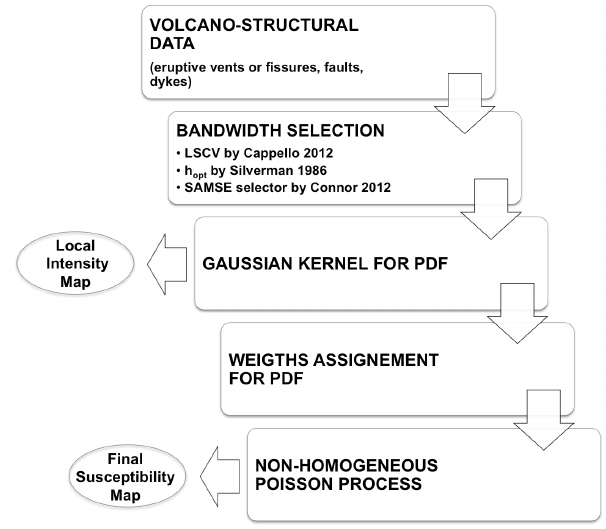
Fig. 1. Flowchart showing the main steps available in